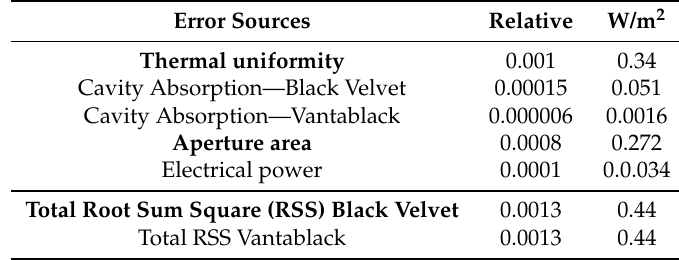
Table 6. Error budget. Relative errors have been calculated in the previous sub-sections. The error